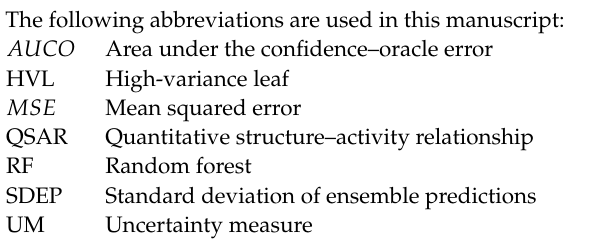
Figure S1: scheme of a fitted regression tree with a high-variance leaf, Figure S2: Python code of the filtering function applied to the activity datasets, Tables S1 and S2: observed vs. predicted scatter plots, Tables S3 and S4: confidence curve plots for 50% data coverage, Tables S5 and S6: uncertainty vs. residual scatter plots, Tables S7 and S8: SDEP vs. HVLs scatter plots, Tables S9–S12: AUCO 50 and declining MSE , Table S13: all datasets used for evaluation, Table S14: distribution of the dependent variables, Table S15: Python packages with